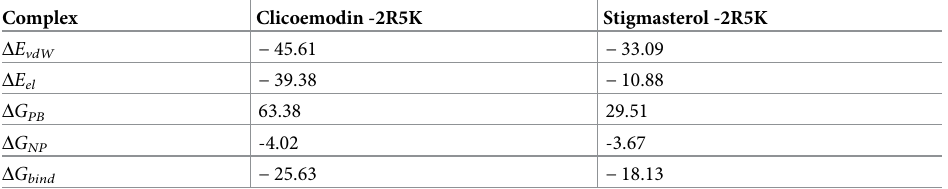
Table 4. Binding free energies and their components for the two complexes: Clicoemodin-1R9W and stigmas- terol-1R9W using the MM-PBSA method. The energy components are in